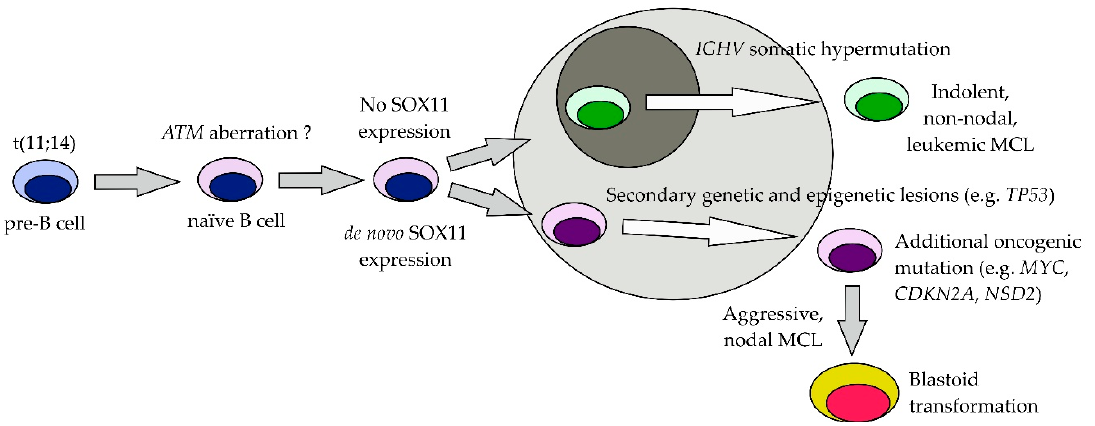
Figure 1. Pathogenesis of MCL . The Figure displays step-by-step accumulation of disease-critical mutations since early acquisition of t(11,14), ATM deletion, de novo expression of SOX11 (in